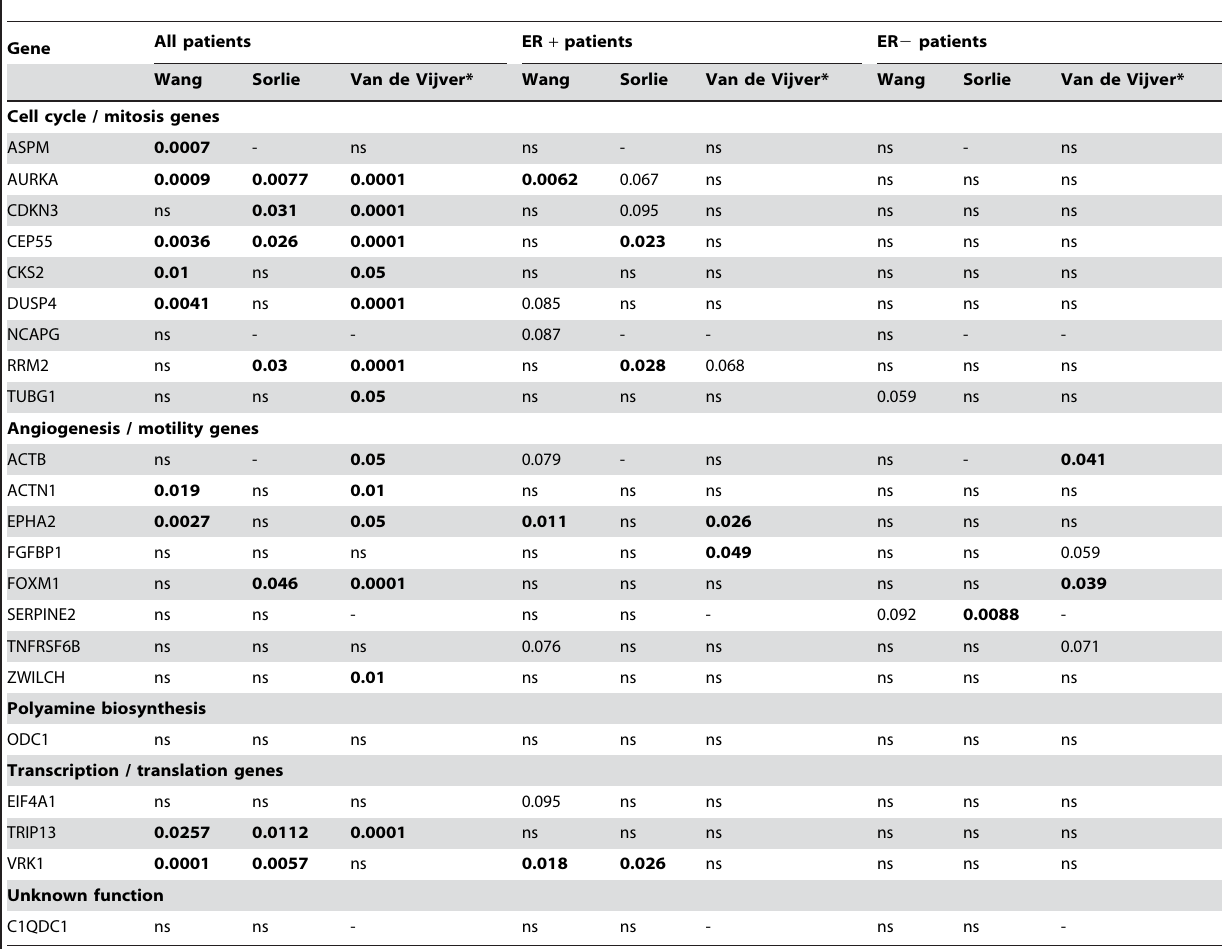
Table 1. Kaplan-Meier p-values for the 22 individual 3D signature genes in the Wang, Sorlie, and van de Vijver patient datasets.